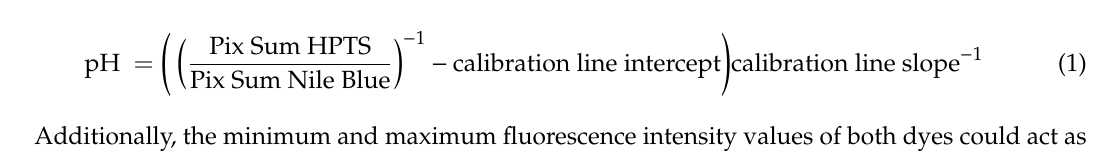
Figure 2. Average quotient of HPTS and Nile blue emission ( a ) its calibration ( b ), HPTS emission intensity raw data points of the calibration ( c ), and Nile blue emission intensity raw data points of the calibration ( d ). Error bars in ( a ) represent the standard deviation of the measurements of three single beads.